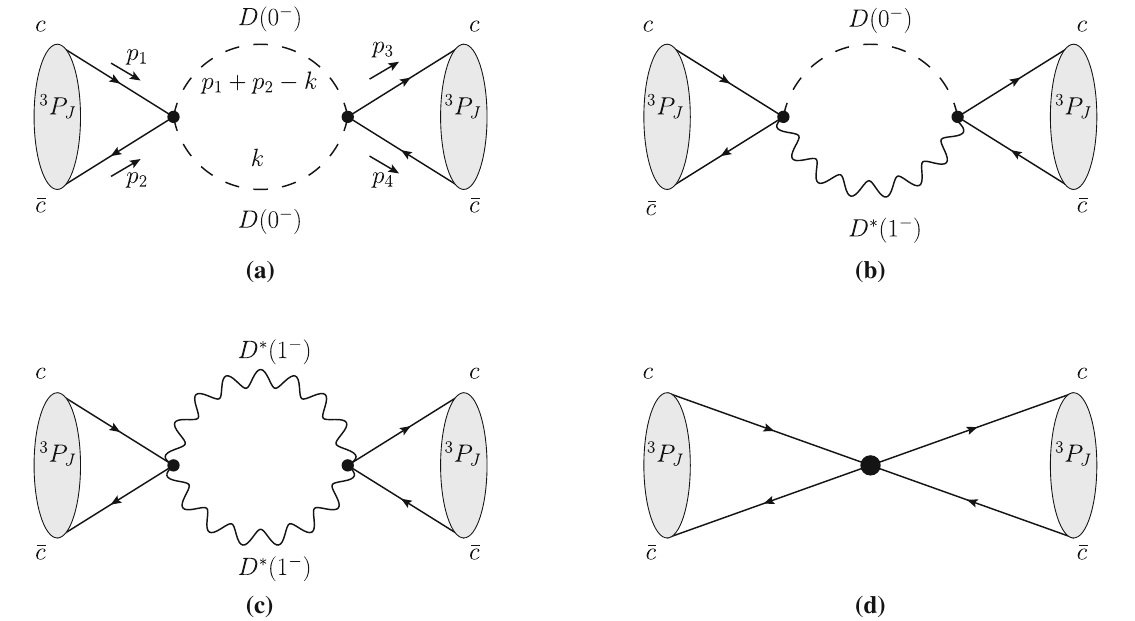
Fig. 1 The diagrams for c ¯ c ( 3 P J ) → c ¯ c ( 3 P J ) processes where a – d are corresponding to c ¯ c → DD → c ¯ c , c ¯ c → DD ∗ → c ¯ c , c ¯ c → D ∗ D ∗ → c ¯ c , and c ¯ c → c ¯ c via contact interactions